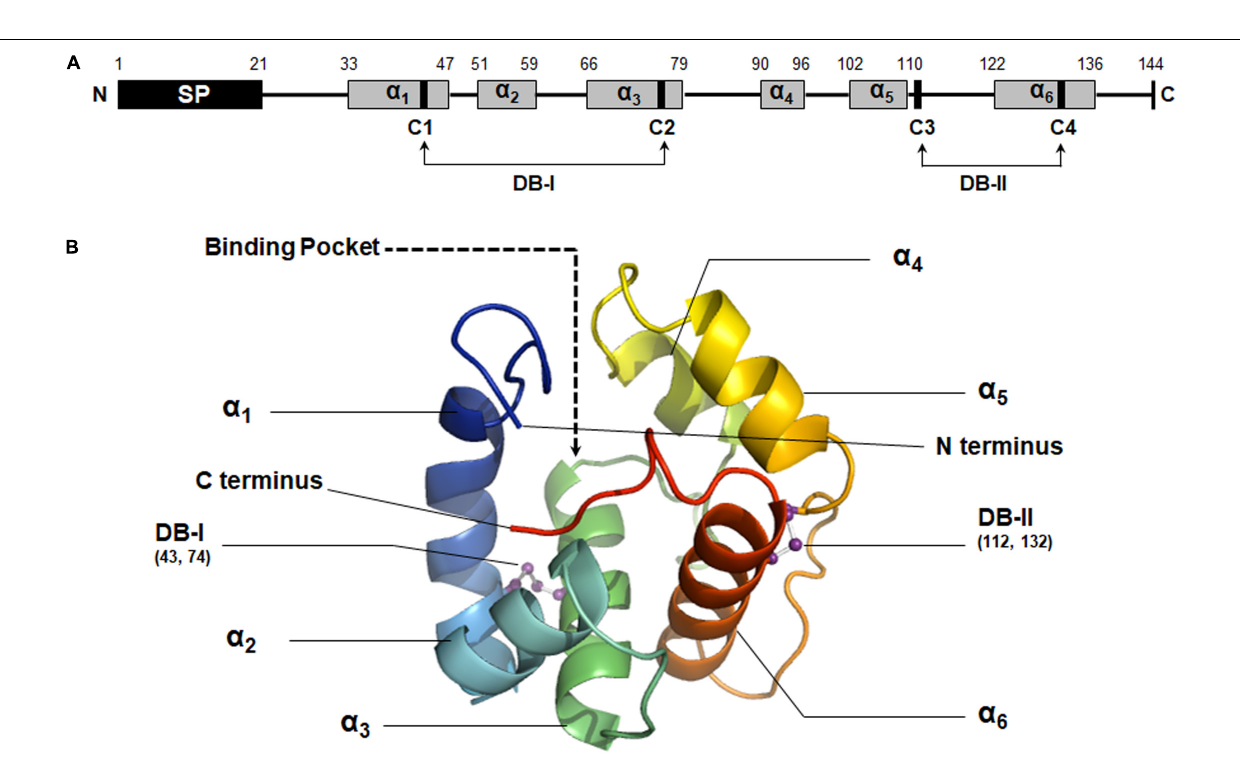
Frontiers in Physiology |